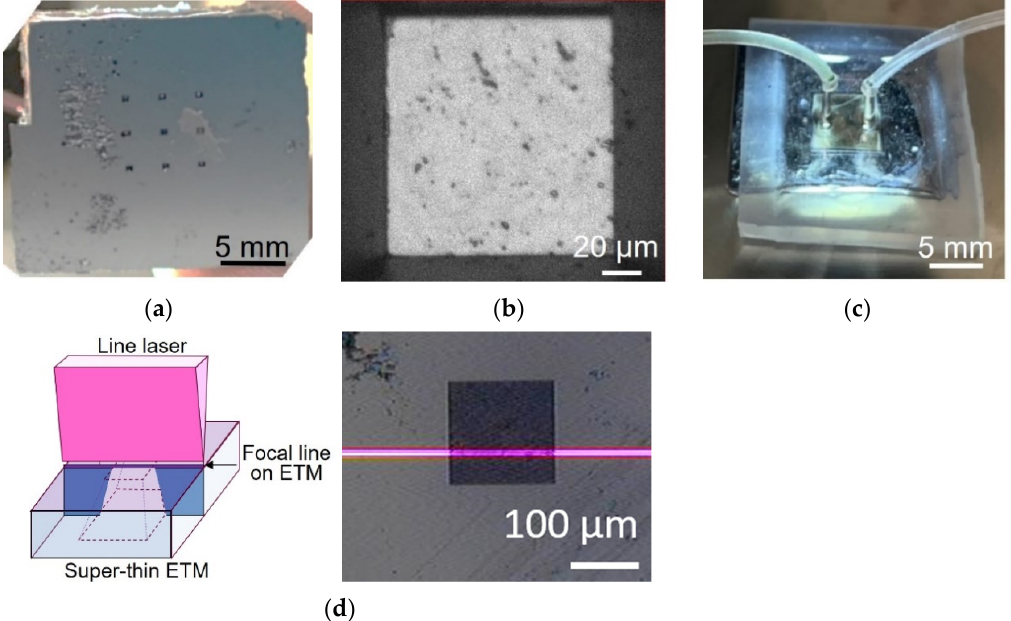
Figure 6. Fabricated microfluidic liquid cell with the super-thin Si 3 N 4 membrane. ( a ) Entire microfluidic liquid cell from the substrate side. ( b ) Close-up image of observation window. ( c ) Entire microfluidic liquid cell from the microchannel side. ( d ) Focused line laser was projected on flat super-thin ETM if the super-thin ETM existed. Focused line laser was not projected if the super-thin ETM was broken. Laser marker was visible on the super-thin ETM.